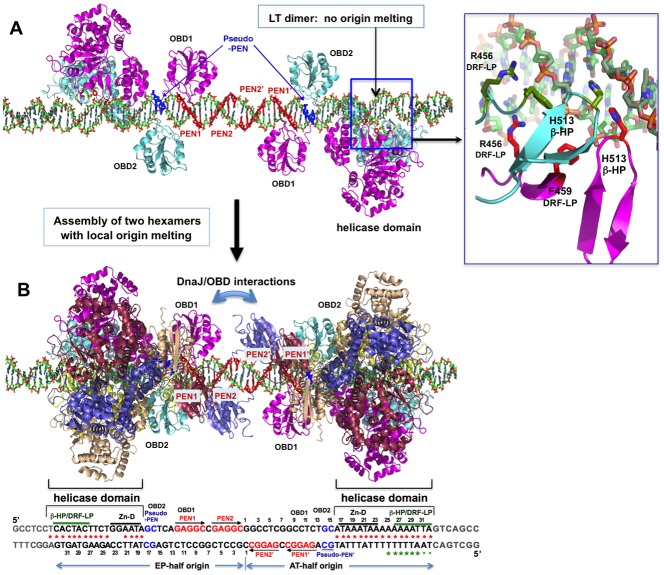
A model for the assembly pathway of the LT double hexamer complex on the viral origin DNA (oriDNA).(A) The assembly of the intermediate complex containing LT dimer bound to each half of the oriDNA, as predicted on the basis of the co-crystal structure of the LT dimer and EP-oriDNA complex (PDBid: 4GDF). The four PENs (penta-nucleotides) and the pseudo-PENs recognized by OBD are colored in red and blue. In this dimer intermediate, PEN2/PEN2’ near the center are not bound by the OBD from the bound LT dimer, probably because the linker to the helicase domain anchored to the AT-rich origin is too short for the OBD to reach PEN2. Dimerization of LT is not through the ODB, but through the helicase domains. The H513 of the β-hairpin (β-HP) and R456/F459 of the DRF-loop contacting the oriDNA are shown in the boxed inset. The oriDNA is not distorted or meltedin this intermediate complex. (B) Assembly of two head-head hexamers from the dimer intermediate in (A), which forms a near-planar closed-ring instead of the lock-washer open-ring, as predicted based on the hexamer-oriDNA structure here and the prior EM studies (Cuesta et al., 2010; Valle et al., 2006). The origin sequences at the bottom are aligned to the known binding locations on the LT double hexamer, in which the AT-rich sequences of the AT/EP halves are bound by the helicase domain. Red stars indicate the melted/distorted AT-rich sequences as identified biochemically upon assembly of LT double hexamer in the presence of ATP (Borowiec et al., 1990; Borowiec and Hurwitz, 1988). The same studies also showed that the melting of the AT-half origin is much less extensive if ADP was used instead of ATP, even though both ADP and ATP induced similar melting on the EP-half origin. Green stars indicate the melted/distorted sequence in the co-crystal structure of the ADP-bound LT hexamer in complex with the AT-half origin (with the two smaller stars indicating less distortion). It is expected that when the changes in LT conformation are coupled to the binding/hydrolysis of cyclic ATP, the extensively melted/distorted oriDNA will be propagated to form a pair of replication forks and thus to initiate DNA replication.